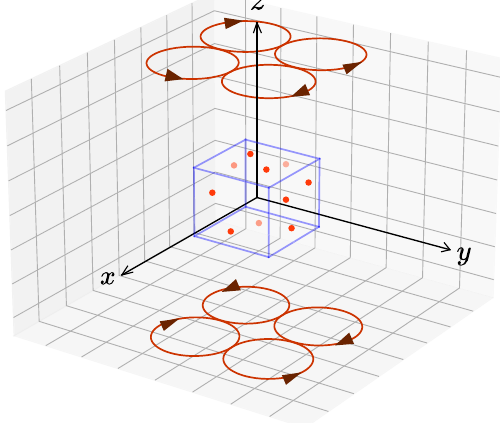
Figure 3. Configuration of the test model. Red circles: current loops, blue cube: cubical sensor array and red dot: triple-axis magnetic field sensors.